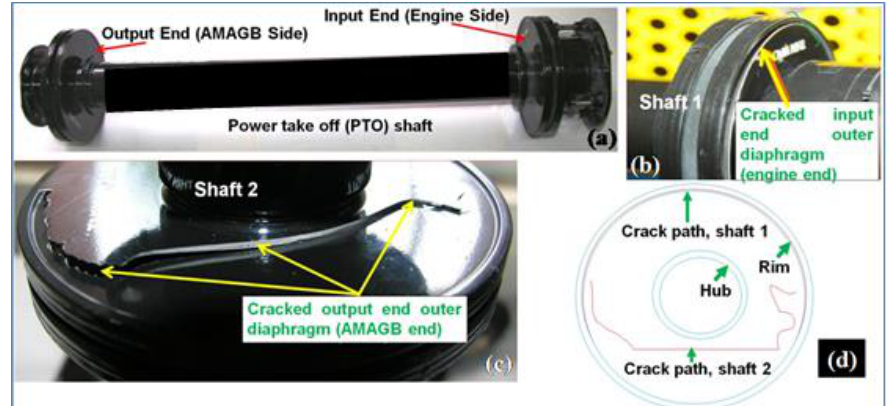
Fig. 5: As-received failed power take off (PTO) shafts – (a) general view, (b) shaft 1, (c) shaft 2, (d) schematic diagram showing the location of crack on diaphragm disc in the failed